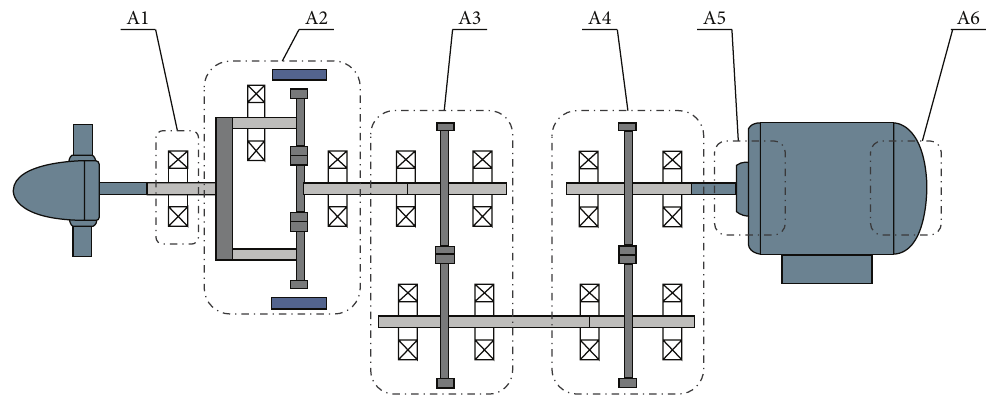
Figure 4: Kinematic scheme of the studied wind turbine.